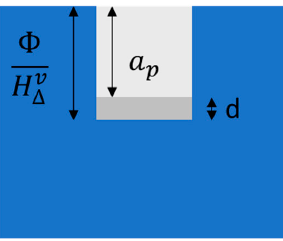
Figure 4. Schematic showing the variables in the thermodynamic theory for evaluation of the depth of cut.